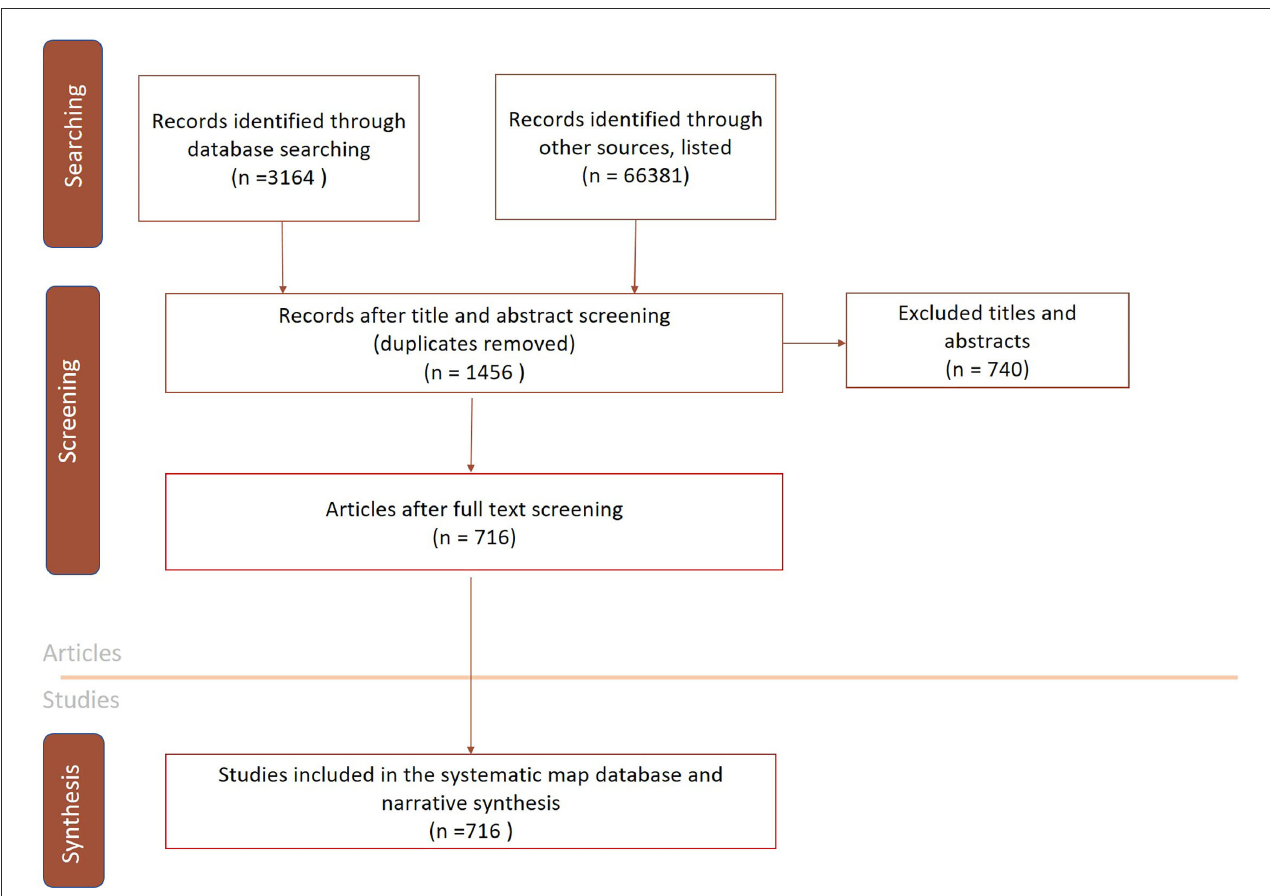
FIGURE1 A conceptual diagram displaying the process of study selection and the respective number of studies included in the systematic map.